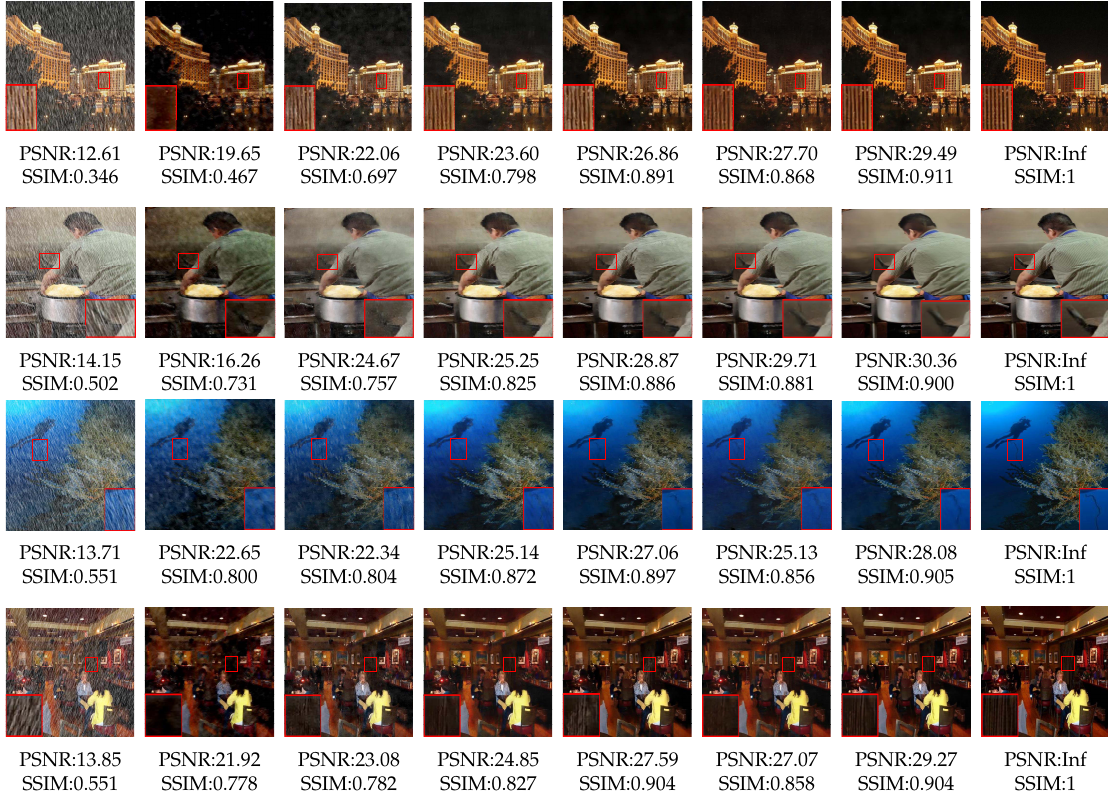
Figure 9. Visual comparison results on synthesic DID-MDN dataset . From left to right: Input, JORDER [8], DDN [7], DID-MDN [6], PReNet [16], GAN-SID [13], Ours, Ground